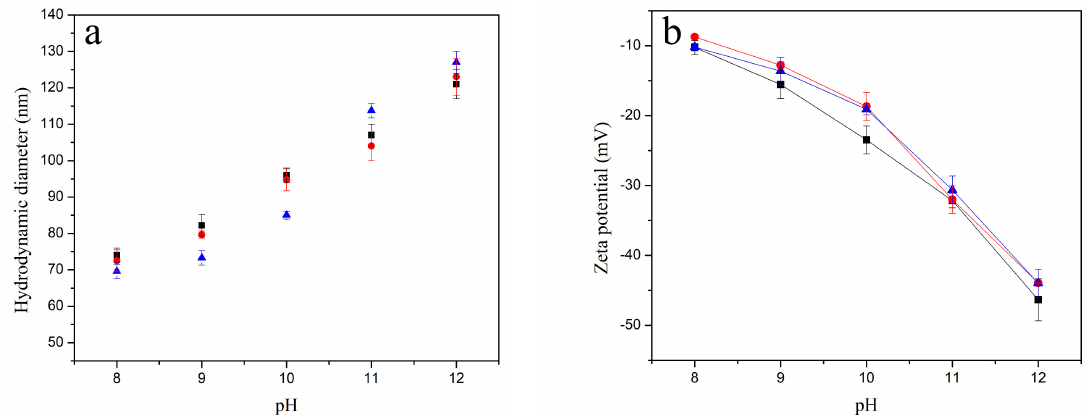
Figure 7. Hydrodynamic diameter ( a ) and zeta potential ( b ) of SiO 2 - g -P(OEGMA 30 - stat -AA 70 ) (black symbols), SiO 2 - g -P(OEGMA 50 - stat -AA 50 ) (red symbols) and SiO 2 - g -P(OEGMA 70 - stat -AA 30 ) (blue symbols) as a function of pH, the measurements were performed at 25 °C. The error bars correspond to standard deviations from three measurements.